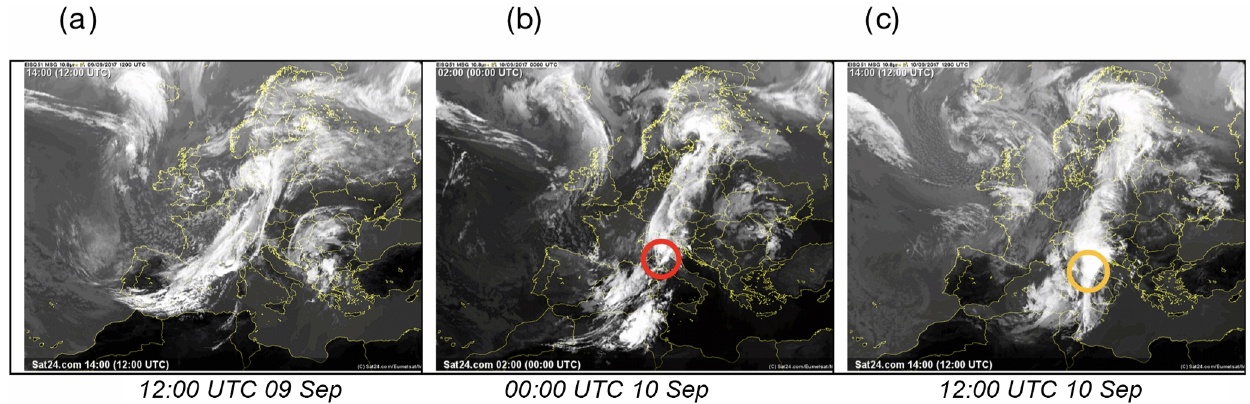
Figure 9. (a) Satellite images (METEOSAT second generation) of the infrared channel, 10.8µm, at 12:00UTC on 9 September 2017, at 00:00 and 12:00UTC on 10 September 2017. The red circle in Fig. 9b and the orange circle in Fig. 9c show the Livorno and Lazio areas, respectively. Source: https://www.sat24.com; © EUMETSAT. Table 1. RAMS@ISAC physical parameterizations used in this paper. Physical parameterization Selected scheme Parameterized cumulus convection Modified Kuo scheme to account for updraft and downdraft (Molinari and Corsetti, 1985). The scheme is applied to R10 only. Explicit precipitation